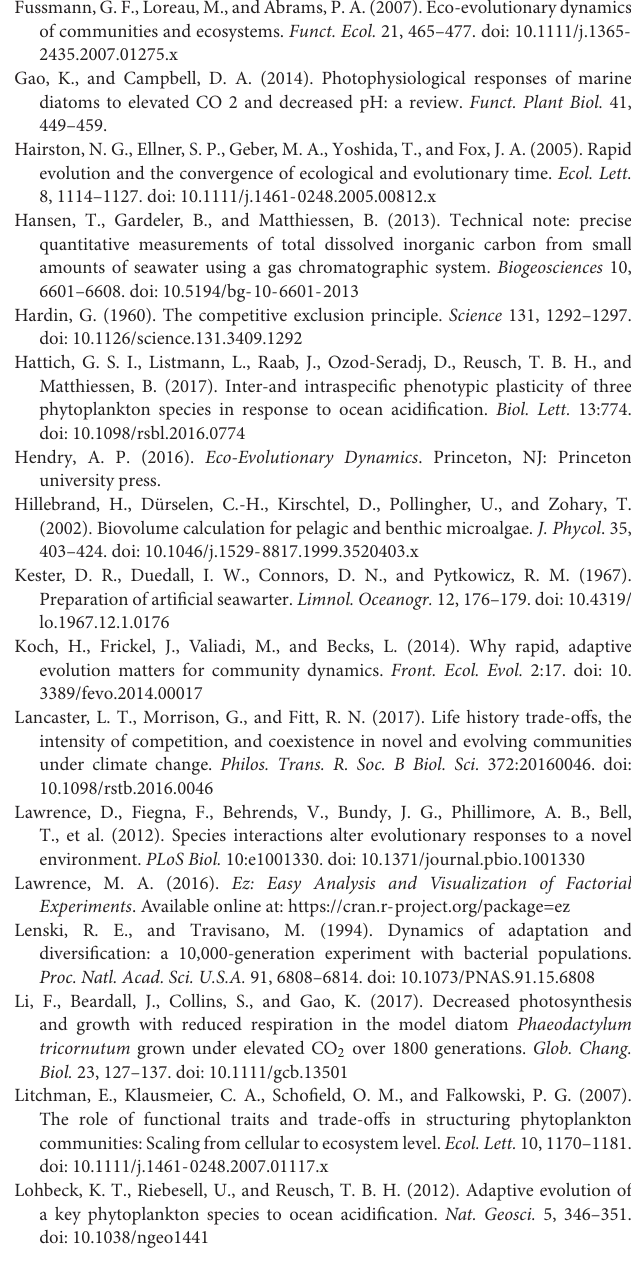
FIGURE S1 | Semi continuous batch cycle growth curves. FIGURE S2 | Dissolved inorganic nutrients in one batch cycle. FIGURE S3 | Estimated growth rates over the course of the experiment. FIGURE S4 | Correlation of cell numbers and biovolume. FIGURE S5 | Correlation of cell volume and biovolume. FIGURE S6 | Relative species contribution to biovolume from a first attempt at the experiment presented here. FIGURE S7 | Relative genotype contribution to biovolume from a first attempt at the experiment presented